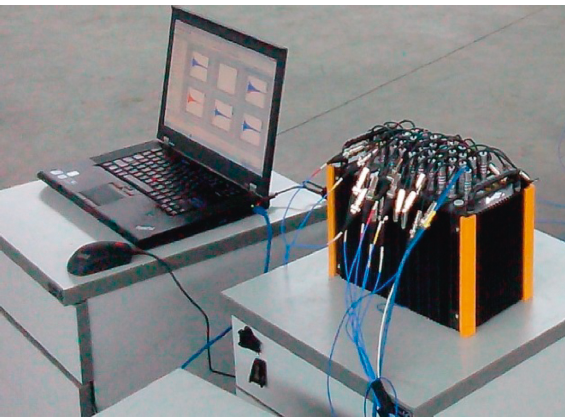
Figure 13: Dynamic signal acquisition instrument.